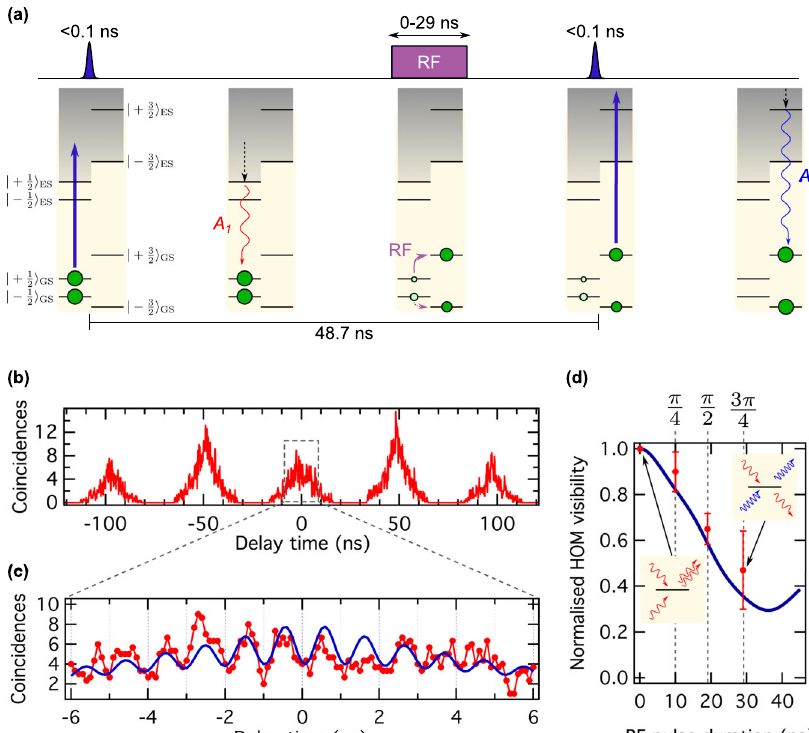
Fig. 3 Distinguishable photon generation by spin control. a Schematics for spin-controlled generation of distinguishable photons from a single h-V Si centre. The sketch shows the realisation when the system is initially in the m subsequent RF pulse with variable duration transfers population (partially) from m line), which makes the two interfering photons maximally distinguishable, and projects the system into the m counts as a function of the delay time for a RF pulse duration of 19 ns (corresponding to a π /2-pulse). The coincidence peak at zero time delay reappears. Data are recorded at 0.1 ns timing resolution and averaged over three points to improve signal to noise. c Zoom-in of the HOM interference pattern revealing the fringe pattern with the expected modulation at 0.965 ± 0.006 GHz. Red dots are uncorrected data, and the blue line is the fi t to the data (for details on the fi t model, see Supplementary Note 7). d HOM contrast as a function of the RF pulse duration. Rabi-like oscillations are observed, demonstrating that coherent spin manipulation controls the degree of photon indistinguishability. Red dots are data and the blue line is the theoretical model considering independently measured Rabi oscillations (see Supplementary Note 4). Error bars represent one standard